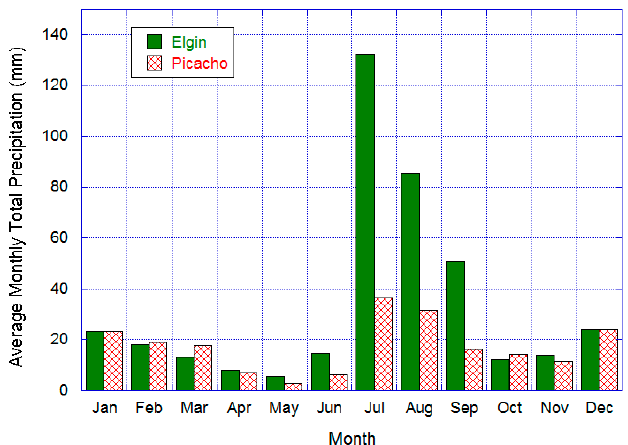
Figure 3. Average (mean) monthly total precipitation for years 2000–2014 at Picacho, Arizona (elevation 492 m) and Elgin, Arizona (elevation 1441 m) [75]. Site locations are displayed in Figure 2.